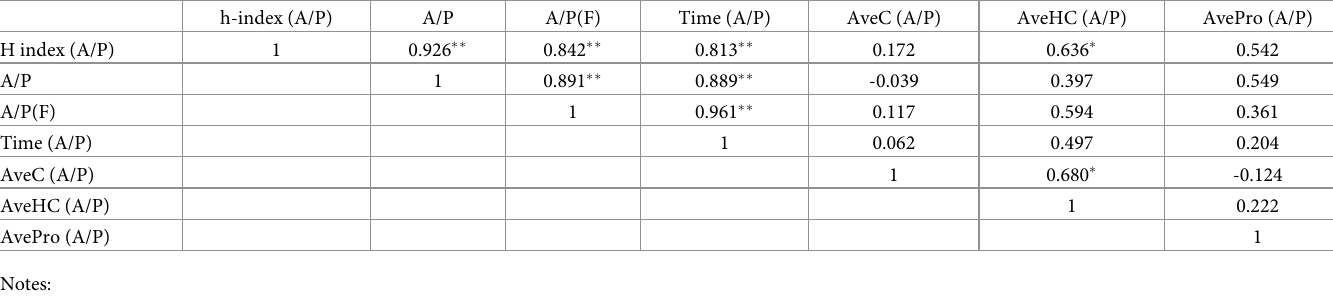
Table 4. Correlations between pairs of